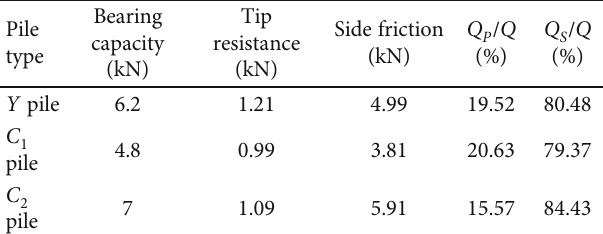
Table 6: Load sharing